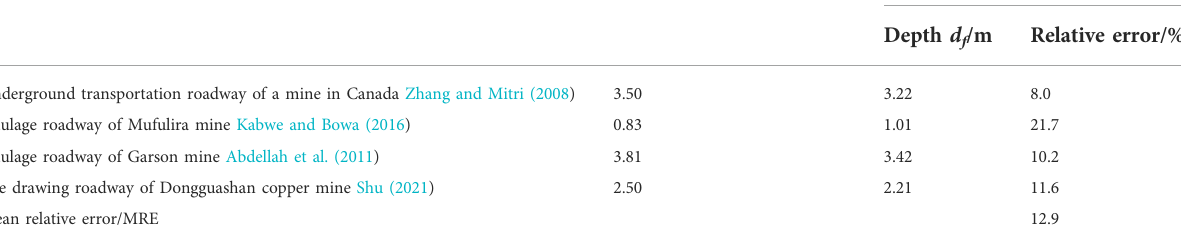
TABLE 3 Comparative analysis of different methods for fracture depth of surrounding rock in